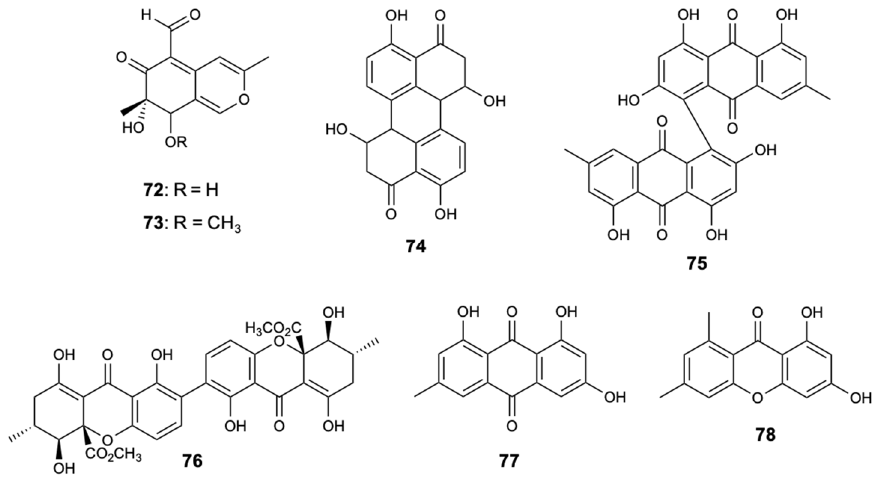
Figure 20. Structures of xanthones and structurally related compounds ( 72 – 78 ).